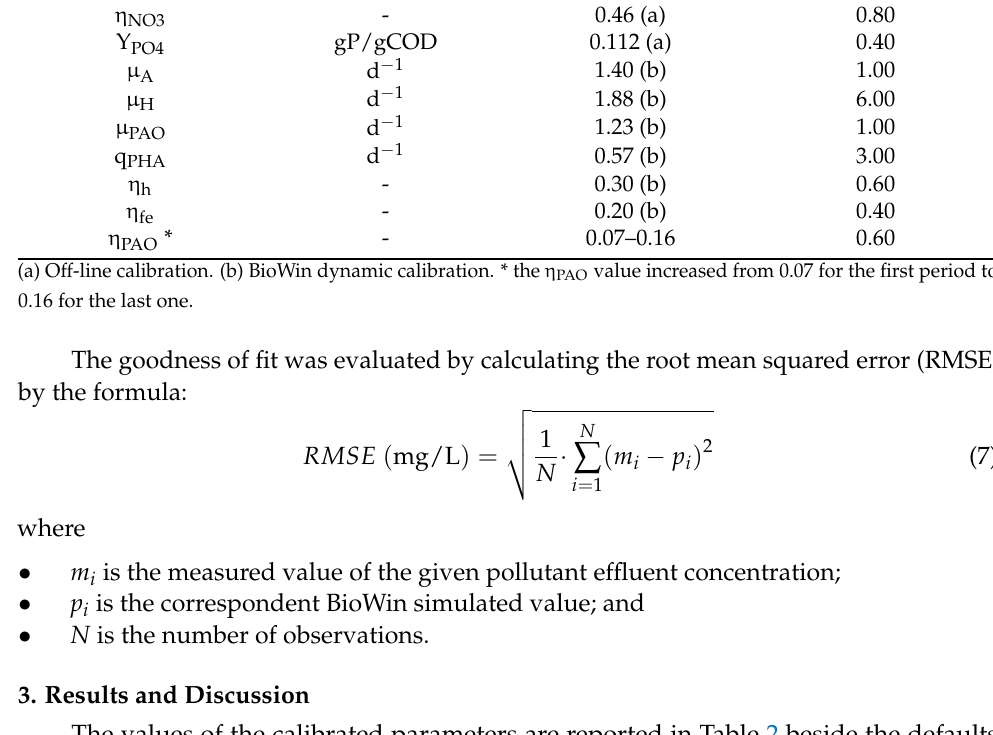
Table 2. Parameter values obtained from calibration process and comparison with the literature values. Parameter Unit Calibrated Default ASM2d η NO3